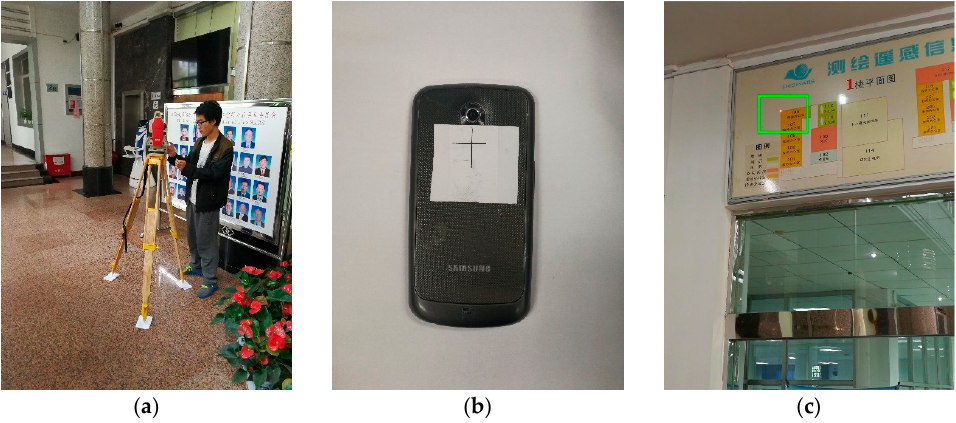
Figure 9. ( a ) The total station; ( b ) The mark on the smartphone; ( c ) The control point measured using the total station.